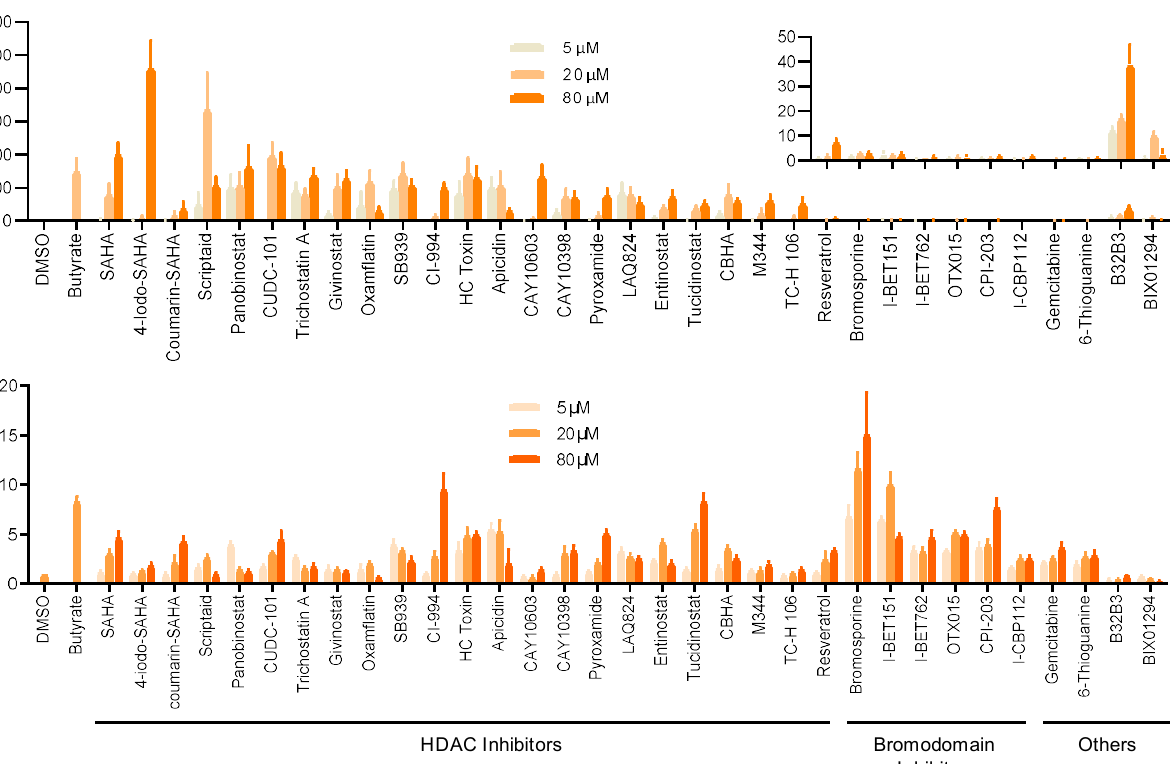
Figure 3. Concentration-dependent activation of the AvBD9 and AvBD10 gene promoters by 33 epigenetic compounds. HTC/ AvBD9-luc ( a ) and HTC/ AvBD10-luc ( b ) luciferase reporter cell lines were stimulated in duplicate with three different concentrations (5, 20, and 80 µM) of each for 24 h, followed by luciferase and cytotoxicity assays. Butyrate (16 mM) and an equal volume of DMSO were used as positive and negative controls, respectively. Fold changes were calculated as relative luciferase activity of a compound divided by that of DMSO-treated cells, after normalization to cell viability. The inset in Panel ( a ) shows the fold changes in the AvBD9 promoter-driven luciferase activity of non-HDAC inhibitors. The results are means ± SEM of three independent experiments.